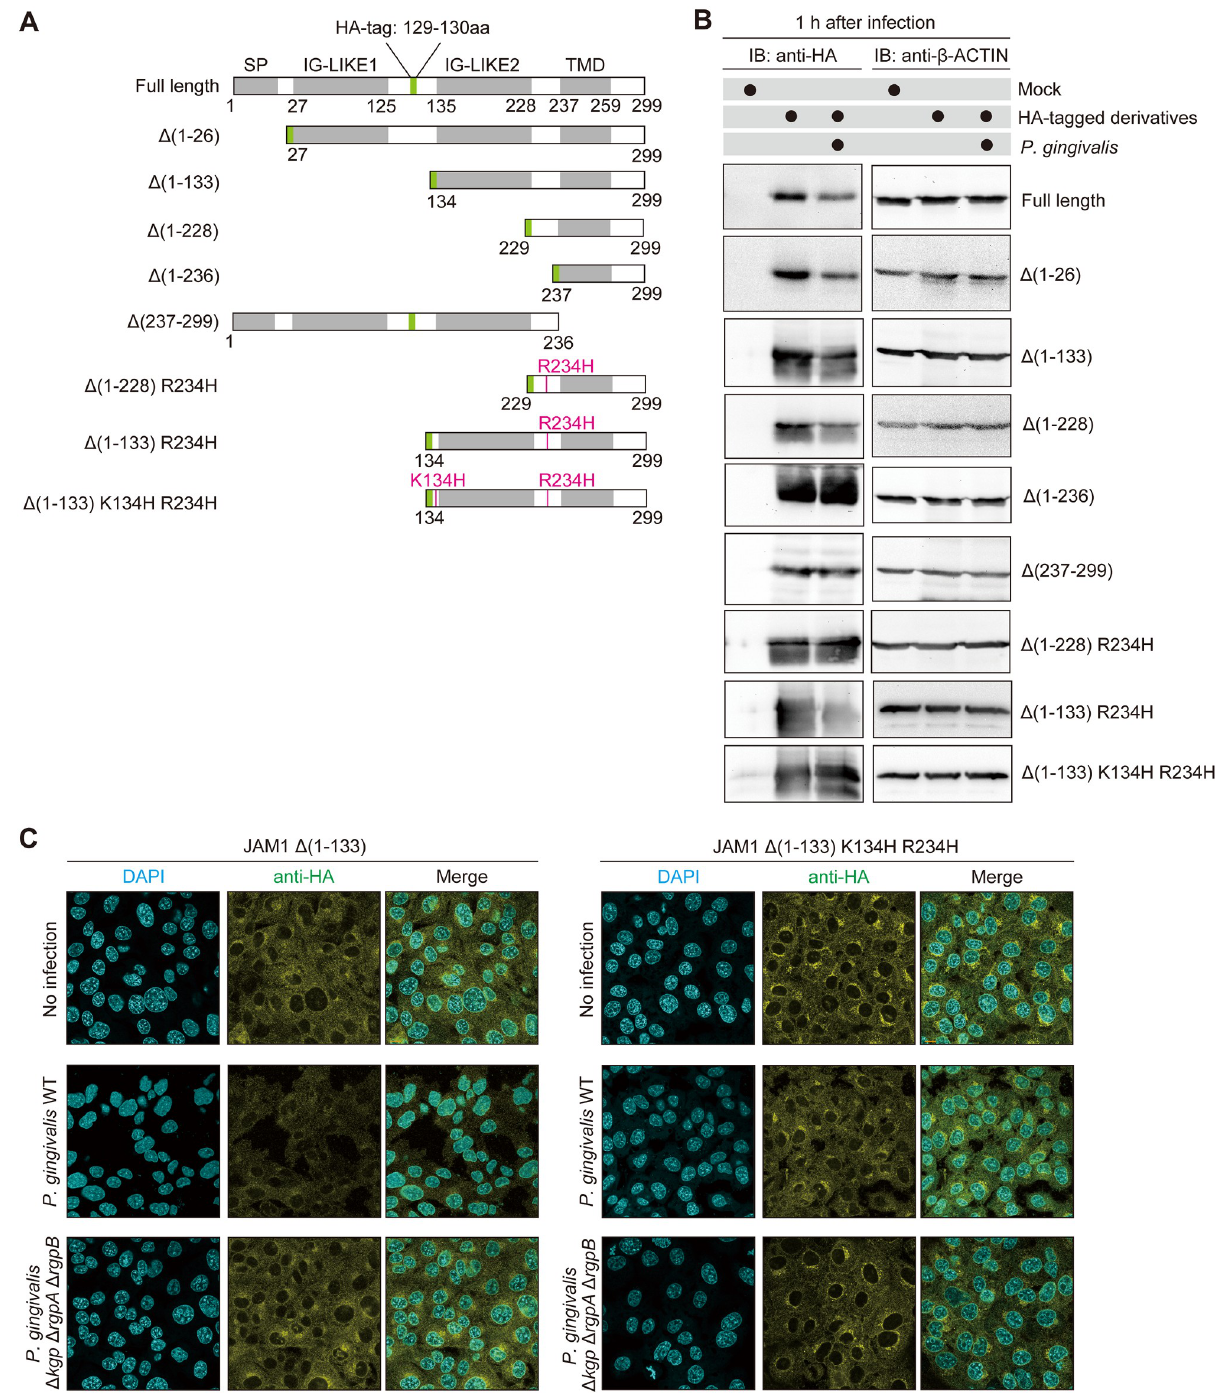
Fig 5. The K134 and R234 residues are involved in degradation of JAM1 by P . gingivalis in IHGE cells. (A) Schematic view of the JAM1 structure and derivatives. SP, IG-LIKE, or TMD domains are indicated by gray boxes. HA-tag is shown in green. The point mutations K134H and R234H are shown in magenta. (B) IHGE cells were transiently transfected with plasmid encoding HA-inserted JAM1 or the indicated JAM1 mutants. Following 48 h of incubation, the cells were infected with P . gingivalis at an MOI of 100 for 1 h, and then analyzed by immunoblotting using the indicated antibodies. (C) IHGE cells stably expressing HA-tagged JAM1 Δ (1–133) or HA-tagged JAM1 Δ (1–133) K134H R234H were infected for 1 h with P . gingivalis WT or the Δ kgp Δ rgpA Δ rgpB mutant at an MOI of 100. The cells were then fixed, stained with DAPI (cyan) and anti-HA (yellow), and analyzed by immunofluorescence microscopy. Scale bars, 10 μ